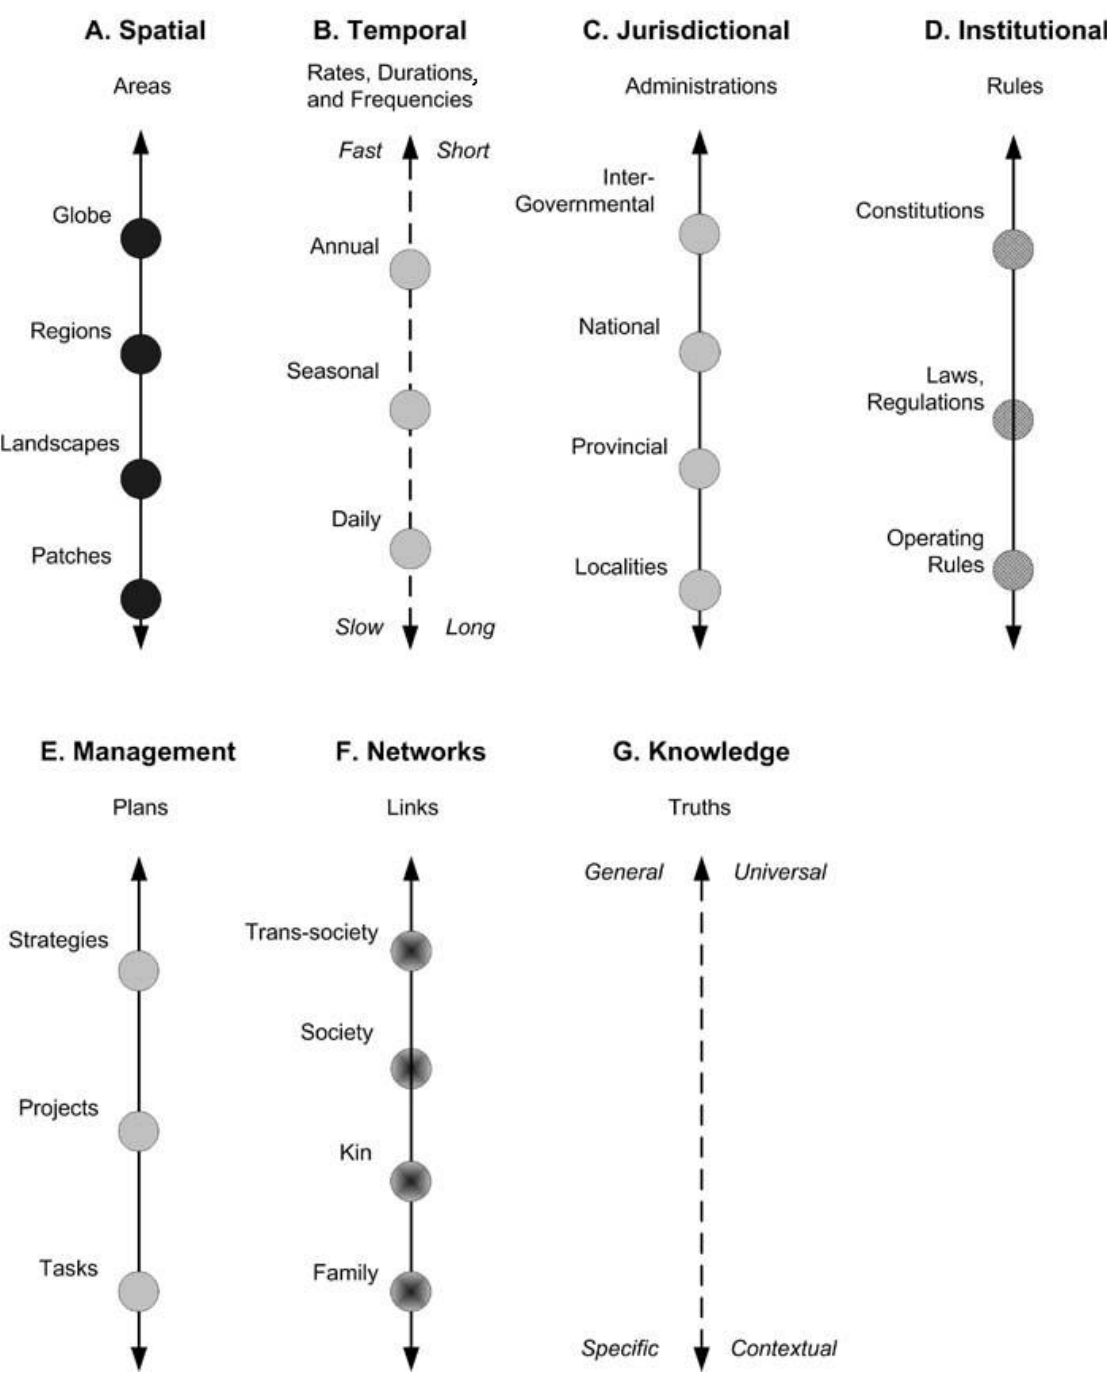
Fig. 1 . Schematic illustrations of different scales and levels that arre critical in understanding and responding to human-environment